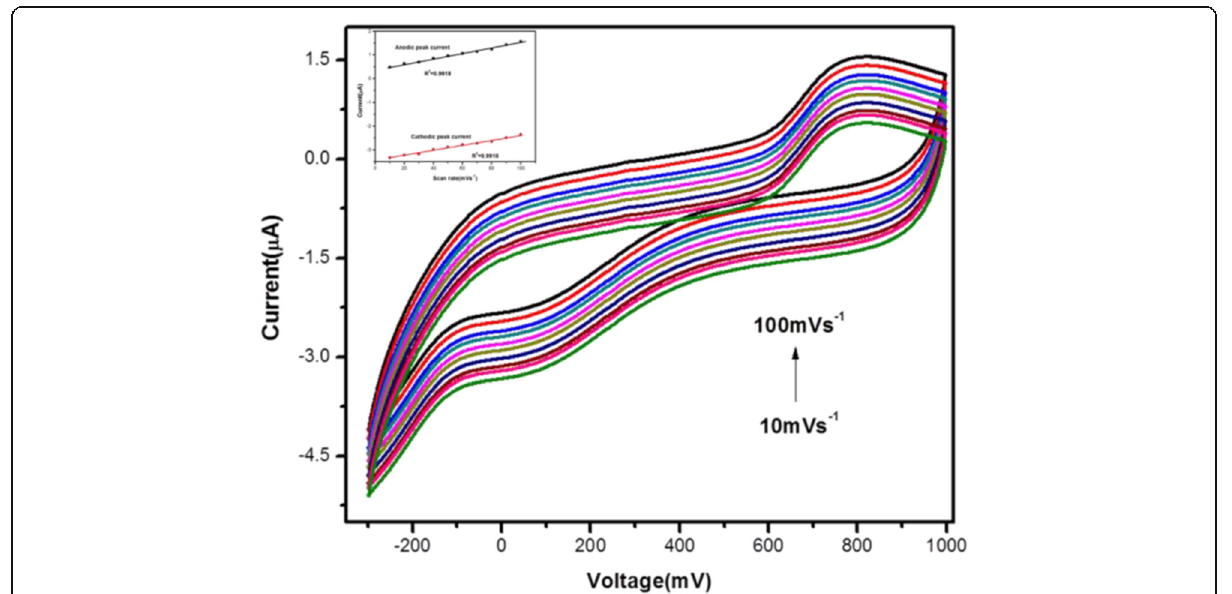
Fig. 10 Cyclic voltammogram obtained at Pt-MWCNT-IIP sensor as a function of scan rate ranging from 10 to 100mV s − 1 and inset shows linear calibration of peak current with scan rate